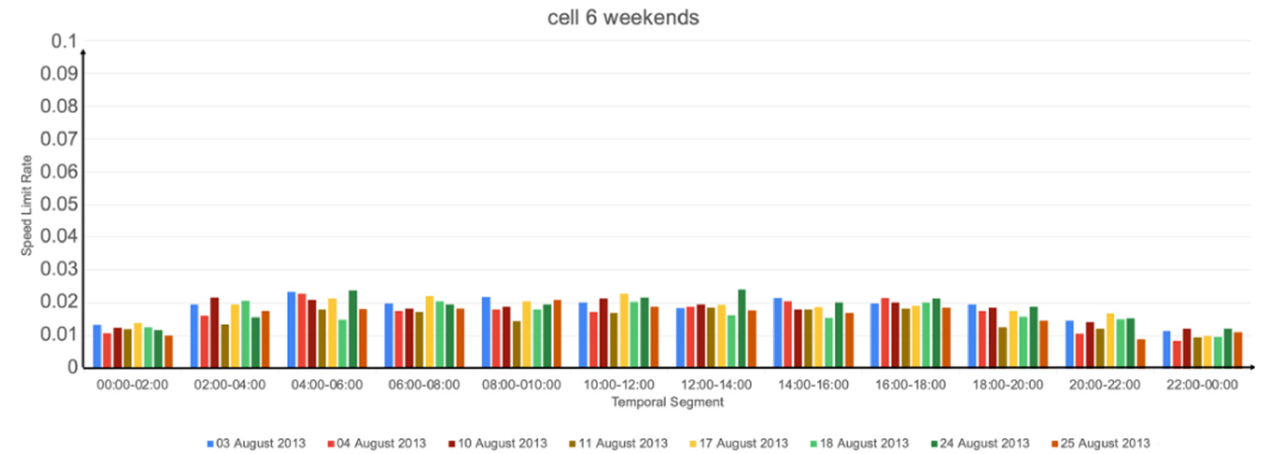
Figure A6. Results for the 28 days, cell 6 with MaxSpeed = 10 km/h in the afternoon.